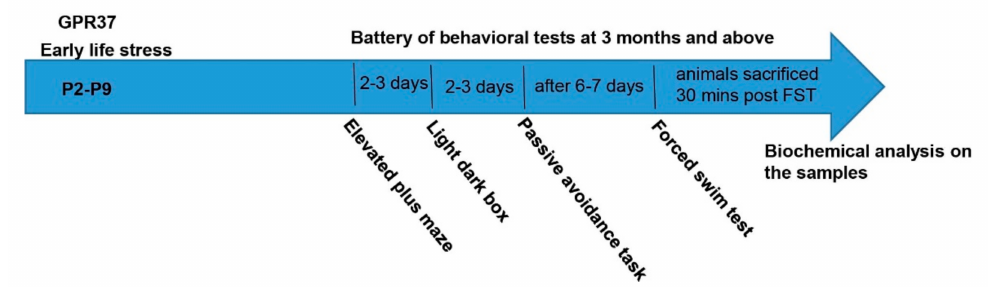
Figure 1. Schematic of the study showing the timelines of early life stress protocol and of the behavioral tests conducted in